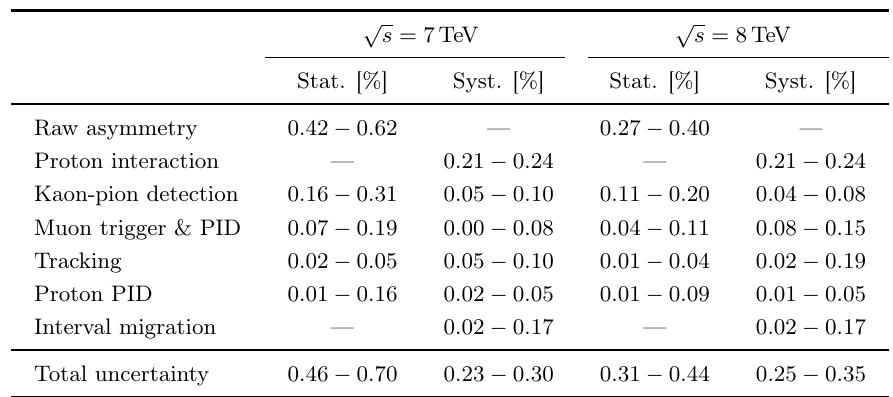
Table 3 . Absolute statistical and systematic uncertainties affecting the measurement, given in percent. The ranges are taken from the results in intervals of (cid:3) 0